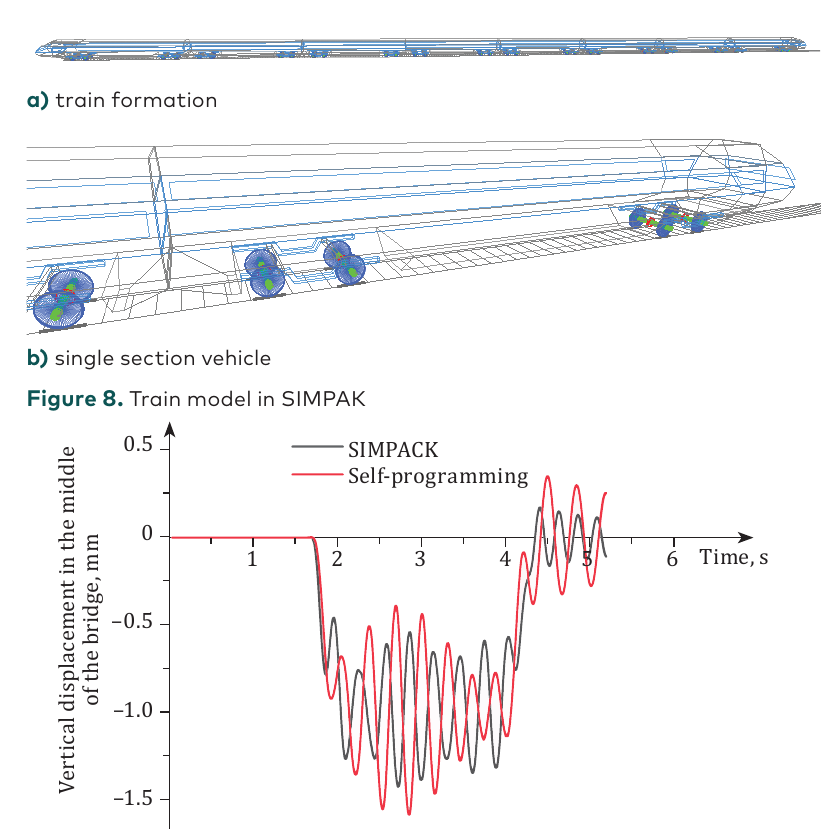
Figure 9. Comparison of vertical displacement time history